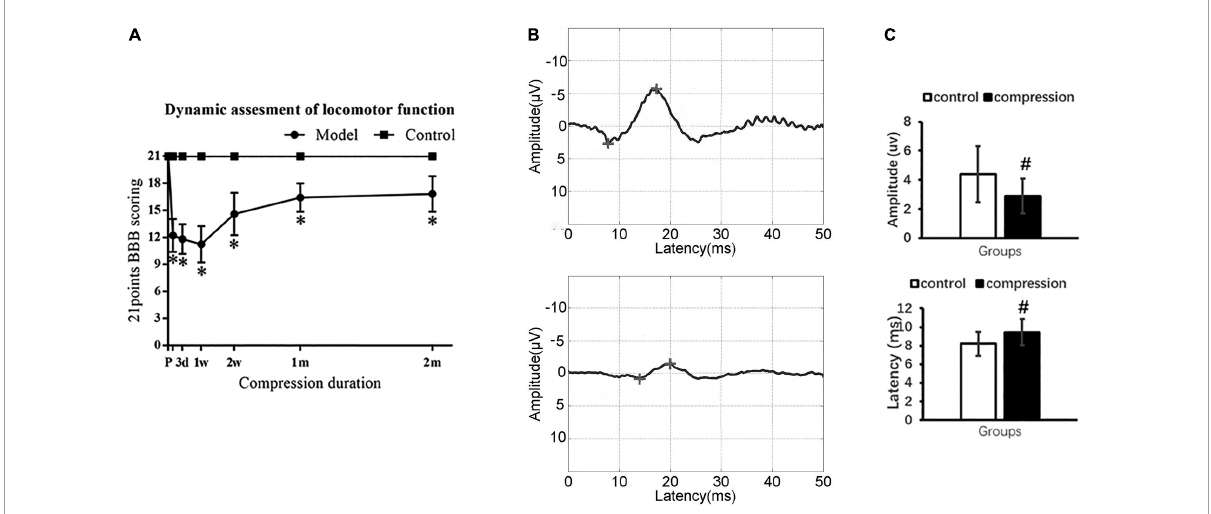
FIGURE2 Neurological dysfunction after compression. (A) Locomotor evaluation with BBB scores. (B) Representative SEP waveforms. (C) Values of SEP amplitude and latency in two groups. “*” compare with the control group at the same time point for BBB scores ( P < 0.05); “#” compared with the control group for SEP ( P < 0.05); CSM group ( n = 12), control group ( n =